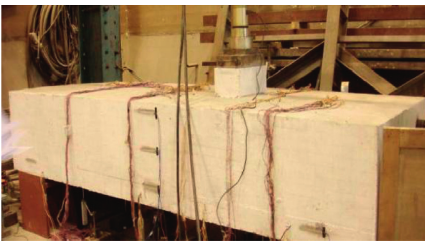
Figure 7: Specimen diagram. Table 2: Mechanical properties of steel bars.